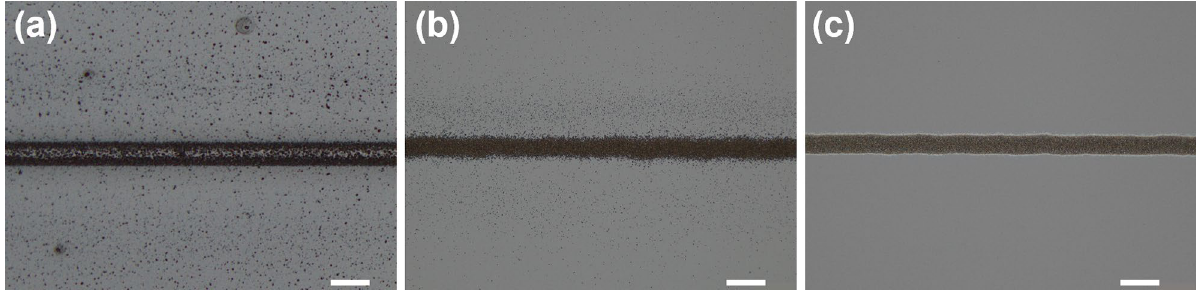
Figure 2. Effect of terpineol on the printed lines: ( a ) No terpineol; ( b ) 5% v/v terpineol; ( c ) 10% v/v terpineol. Printing parameters: 100 µm nozzle, sheath gas flow rate 20 SCCM, carrier gas flow rate 10 SCCM, scanning speed = 2 mm/sec, working distance = 2.5 mm. Scale bar 50